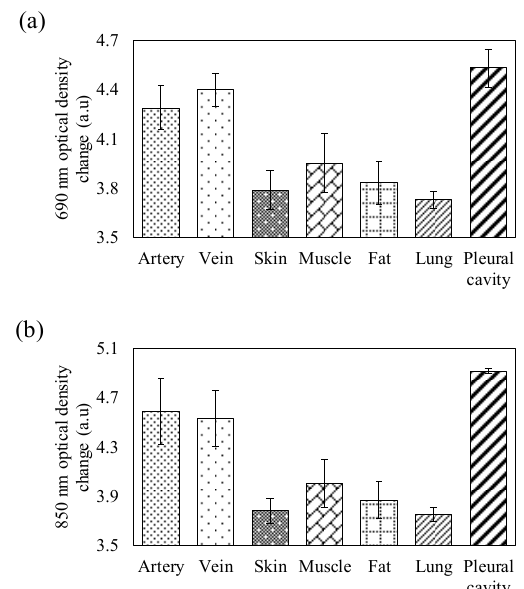
Figure 4. Average optical density changes of different tissues corresponding with ( a ) 690 nm and ( b ) 850 nm wavelengths in the in vivo experiment.